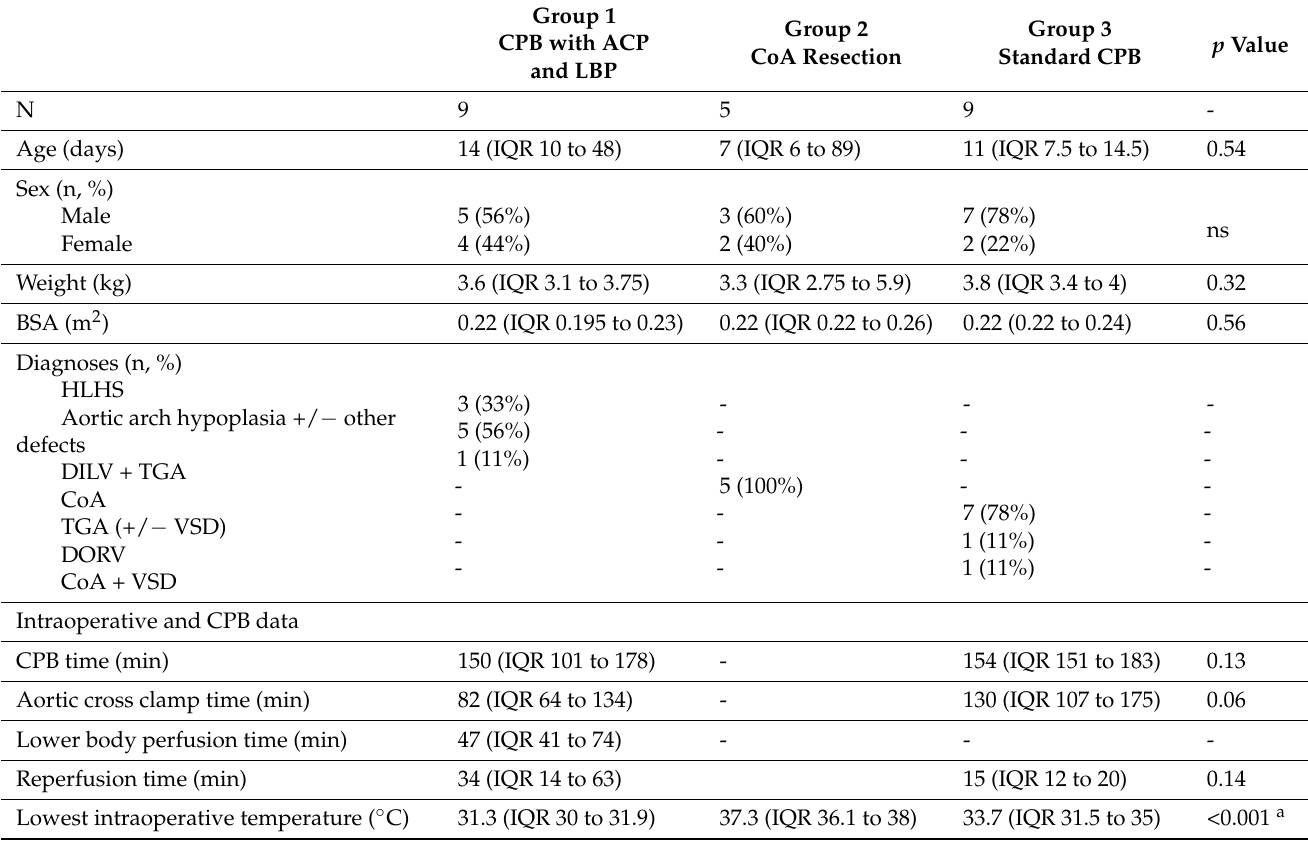
Table 1. Patient characteristics and intraoperative